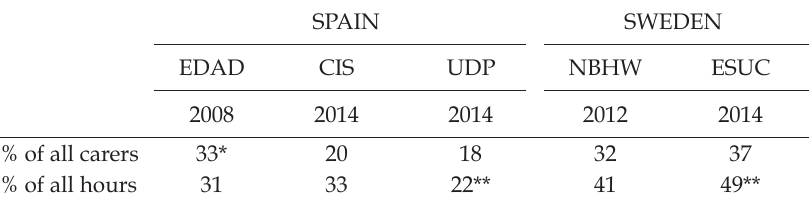
Table 2. Proportion of older persons among all caregivers, and in all hours of caregiving, Spain and Sweden, selected years SPAIN SWEDEN EDAD CIS UDP NBHW ESUC 2008 2014 2014 2012 2014 33* 20 18 32 37 31 33 22** 41 49**